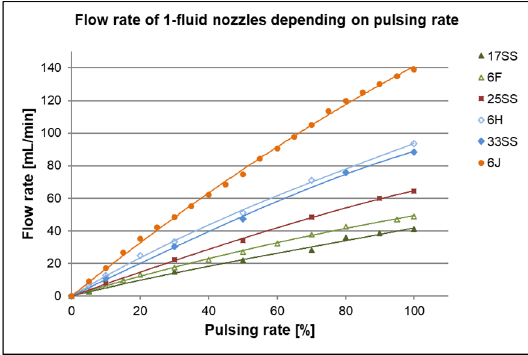
Figure 9. Flow rate of each spraying nozzle at different pulsing rates, measured at 2.5 bar with 1,4-dioxane. 100% means mass flow at fully opened spraying nozzle without pulsing.